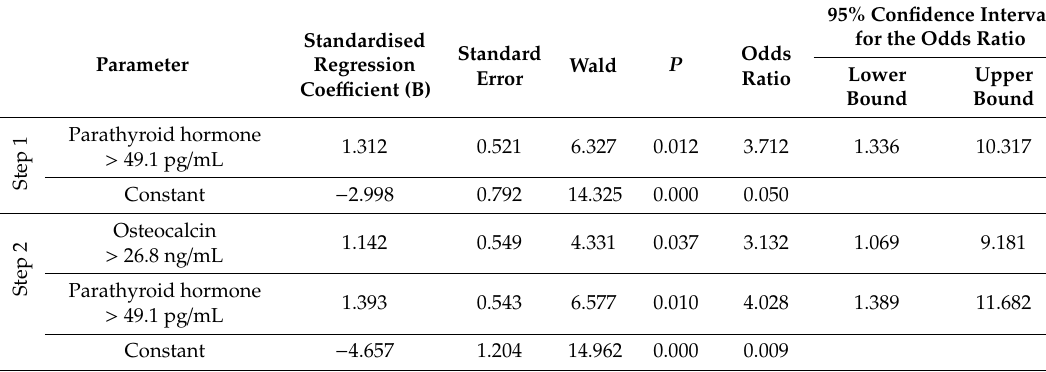
Table 8. Significant variables predicting an adverse cardiovascular outcome in stepwise logistic regression analysis.